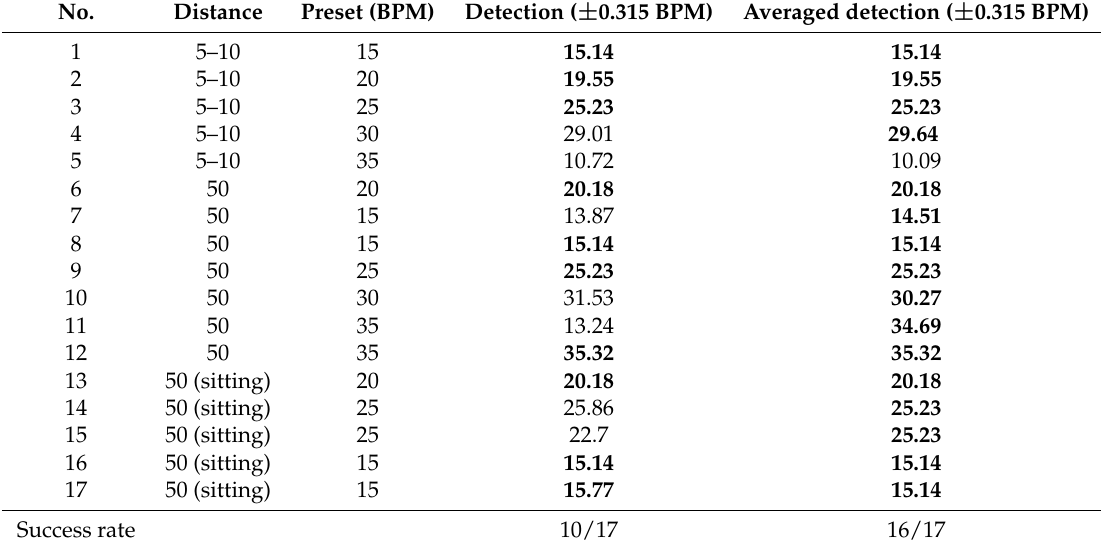
Table 1. The detected respiration rates for different test cases. The bold numbers indicate successful